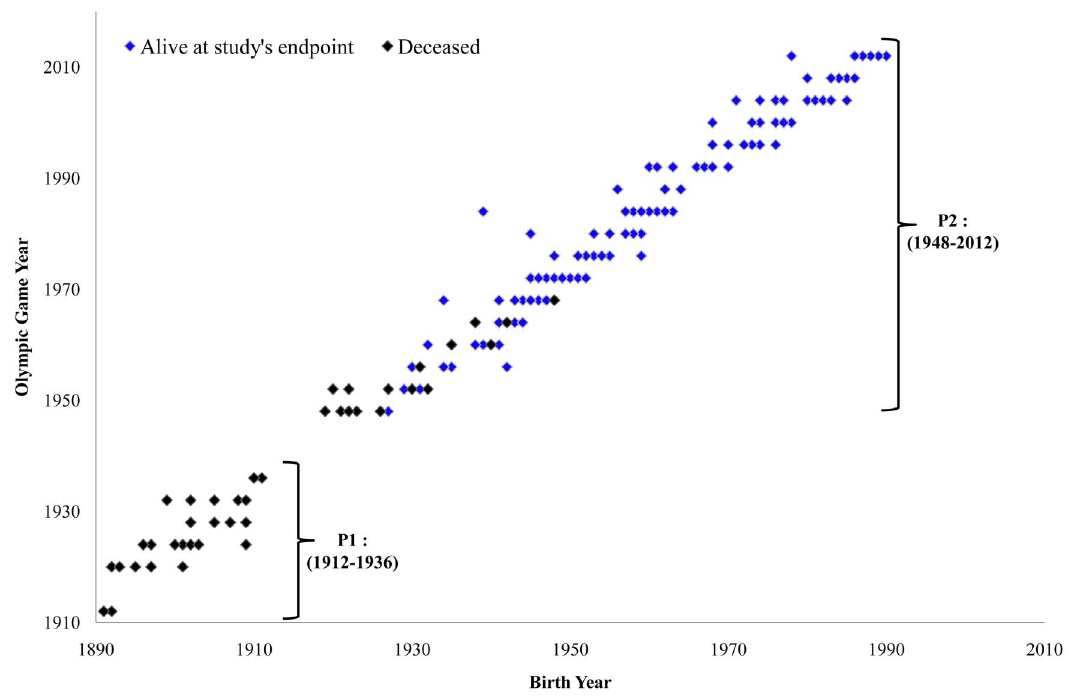
Figure 1. French Olympic rowers by Olympic Games and birth year. Black diamond represents deceased subjects and blue diamond represents the subjects alive at the study’s endpoint. The two periods studied apart are schematically indicated.